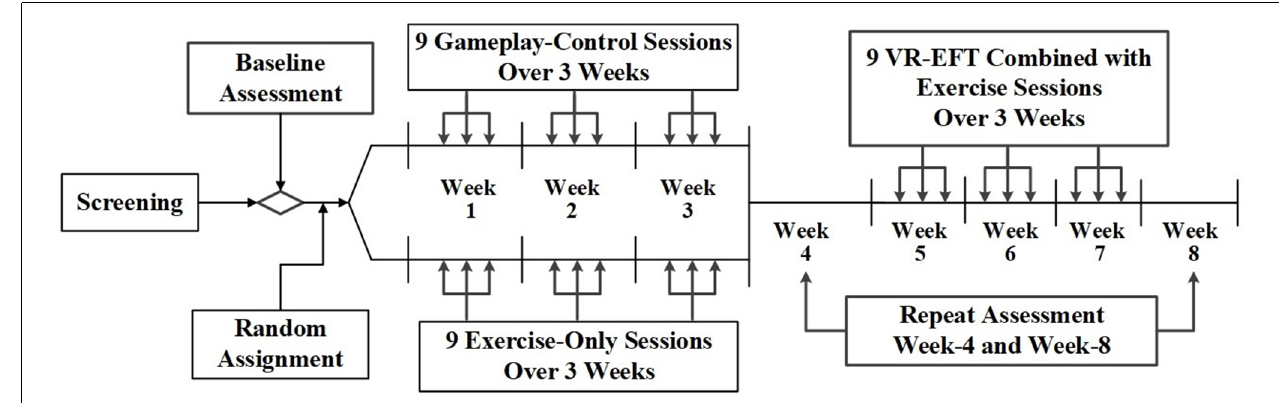
FIGURE 1 | Virtual reality executive function training study